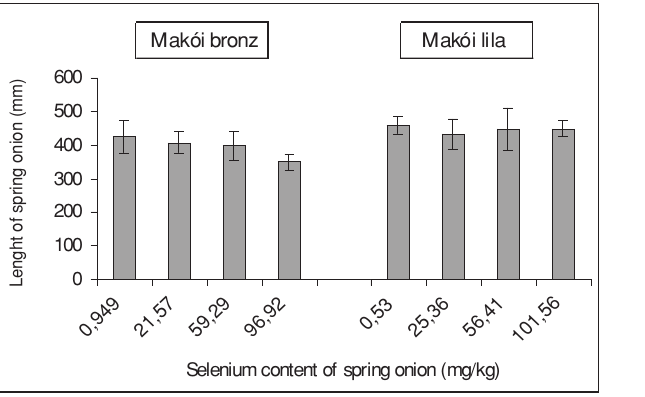
0100200300400500600 57 29 949 92 21 , 59 , 96 , 0 , Selenium content of spring onion Fig. 5: Correlation between length and total selenium content of spring onion